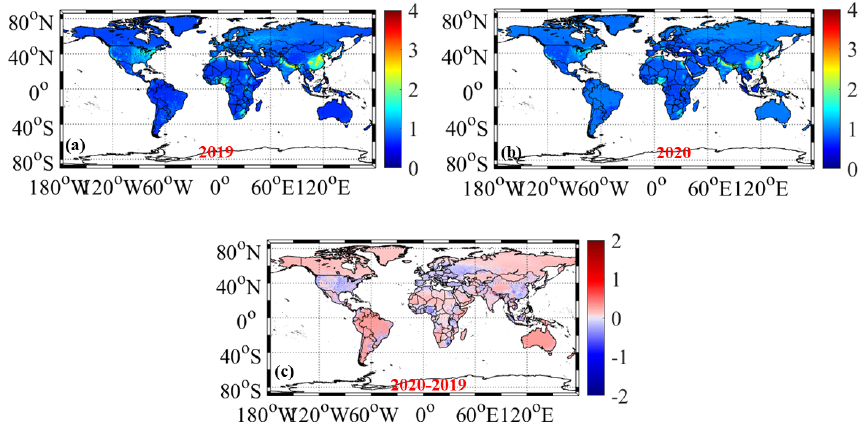
Figure 2. The global average deweathered benzene concentrations in 2019 (23 January–30 June) (a) and 2020 (23 January–30 June) (b) . Panel (c) represents the difference in deweathered benzene concentrations in 2020 and 2019 (unit: µgm − 3 ).